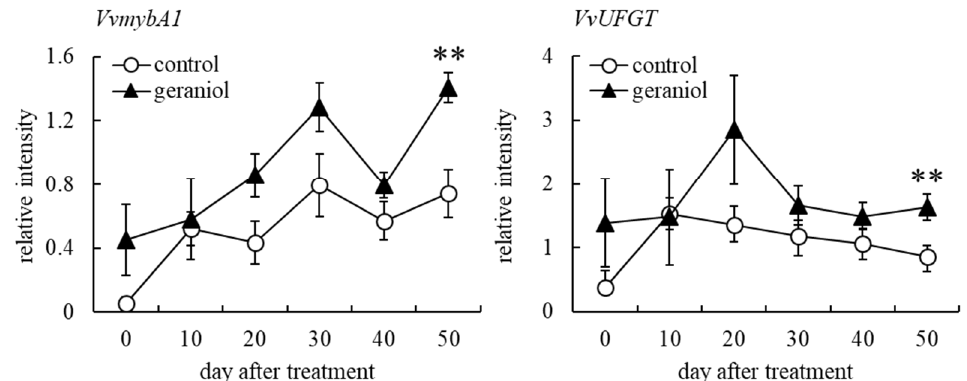
Figure 3. Effect of geraniol on transcription of VvmybA1 and VvUFGT in grape berry skins. Bunches of field-grown grapevines were treated with 10 nM geraniol as shown in Figure 1. Transcription levels of VvmybA1 ( left ) and VvUFGT ( right ) in berry skins were estimated by real-time RT-PCR. Data were calculated as gene expression relative to β-actin expression. Bars indicate means ± standard errors for four bunches. ** p < 0.01 compared with control. Geraniol, treated with 10 nM geraniol. Control, treated with diluted ethanol.